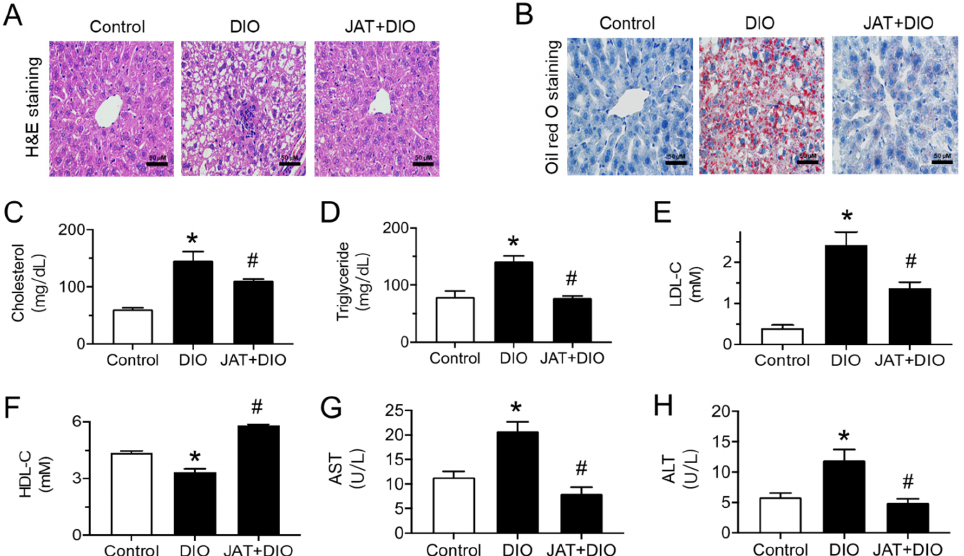
Figure 8. Effect of jatrorrhizine on liver and plasma lipid profile in DIO mice. ( A , B ) Representative images of H&E staining and oil red O staining sections of livers from mice (scale bar: 50 μ m). ( C – H ) Plasma levels of total cholesterol, triglyceride, low-density lipoprotein cholesterol (LDL-C), high- density lipoprotein cholesterol (HDL-C), aspartate aminotransferase (AST) and alanine aminotrans- ferase (ALT) measured by corresponding test kits. Data are mean ± SEM from six mice for each group. * p < 0.05 vs. Control; # p < 005 vs. DIO. 2.6. Jatrorrhizine Treatment Activates Akt/eNOS Pathway and Suppresses ER Stress and Oxidative Stress in Aortas of DIO Mice To find whether chronic JAT treatment impacts ER stress and oxidative stress, West- ern blotting and dihydroethidium (DHE) staining were conducted. We found that the ex- pression levels of ER stress markers, including phosphorylation of JNK at Thr 183 /Tyr 185 and eIF2 α at Ser 51 , cleaved ATF6 and spliced XBP1, were significantly higher in aortas from DIO mice than in the control, whereas JAT treatment reversed these changes (Figure 9A). JAT elevated Akt and eNOS phosphorylation in DIO mice (Figure 9B,C). Additionally, the enhanced ROS level was effectively inhibited by JAT treatment in mouse aortas (Figure 9D).